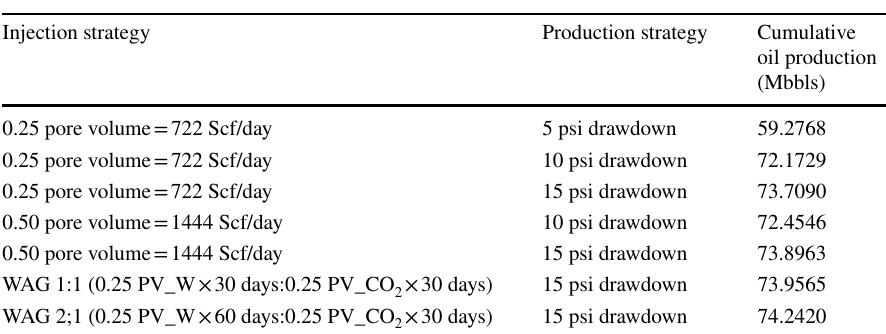
Table 5 Actual cumulative Injection strategy Production volumes in response to varying injection/production strategies for optimizing oil recovery